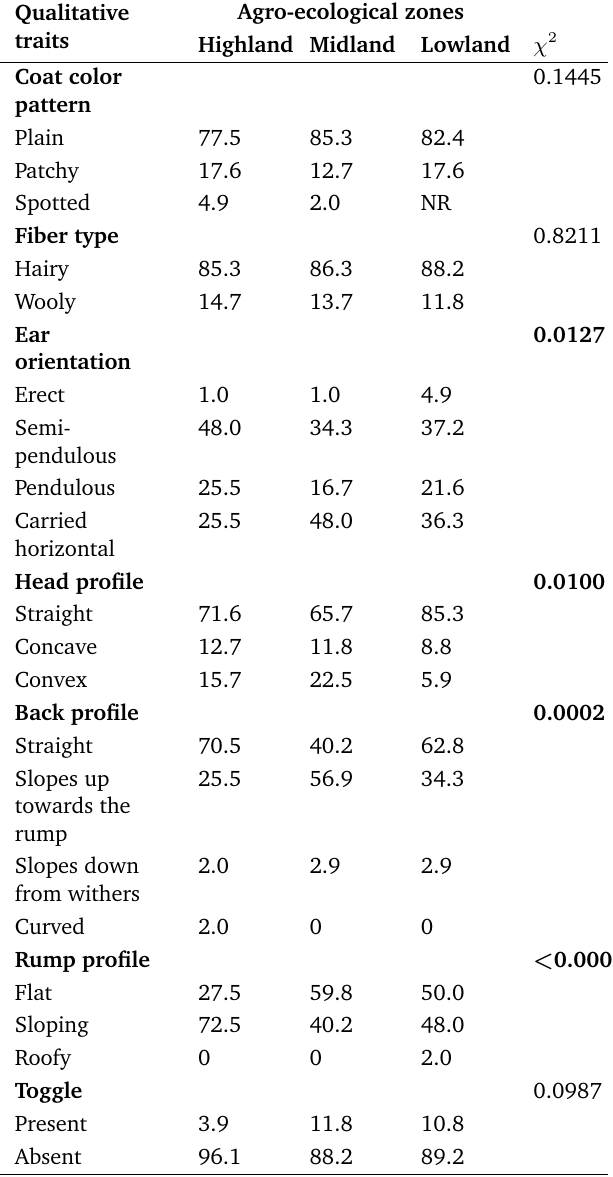
Table 5. Percentages and their respective chi-squared proba- bilities of some qualitative characteristics of the sheep popu- lations from different agro-ecological zones. χ 2 values in bold are statistically